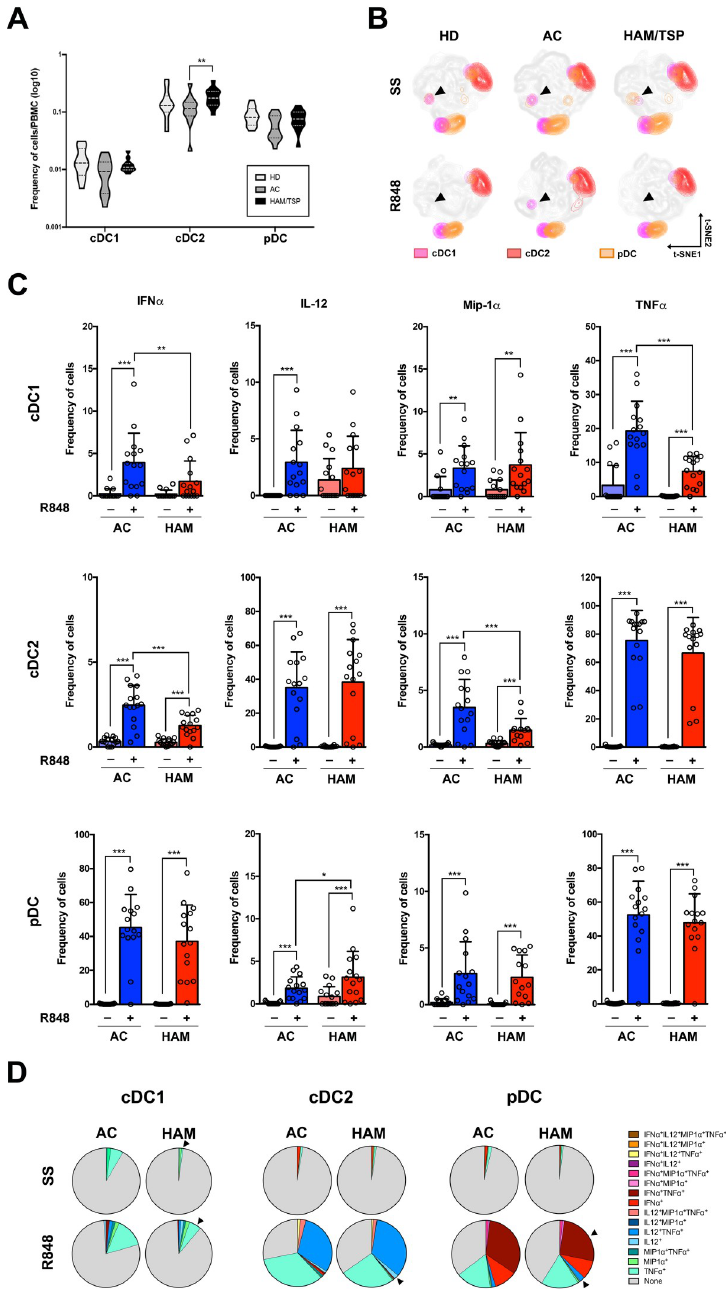
Fig 2. Dendritic cells of HAM/TSP patients present impaired response to stimulation. (A) Frequency of dendritic cell subsets (cDC1, cDC2 and pDC) among PBMCs in the clinical groups at steady state. HD: healthy donor; AC: asymptomatic carriers; and HAM/TSP: HTLV-1 associated myelopathy/Tropical spastic paraparesis (B) tSNE analysis of DC subsets in innate cell populations at steady state and after TLR7-stimulation with R848. (C) Frequency of the cells producing IFN α , IL-12, MIP-1 α and TNF α at steady state and after R848 treatment in the different DC subsets. Statistical significance was determined using one-way ANOVA followed by Turkey post-hoc test. � p-value � 0.05; �� p-value � 0.01; ��� p-value � 0.001. (D) Pie-chart of the Boolean analysis, using the data from all samples of each clinical groups, for the cytokine production in DC subsets at steady state (SS) and after TLR7 stimulation (R848).